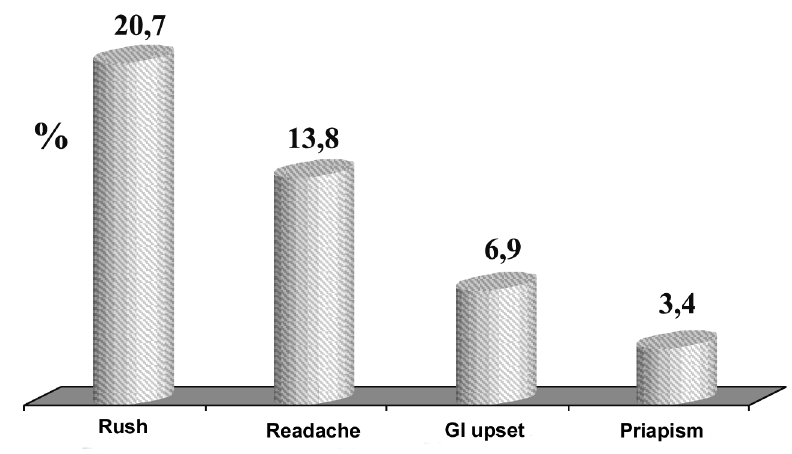
Figure 3 – Adverse